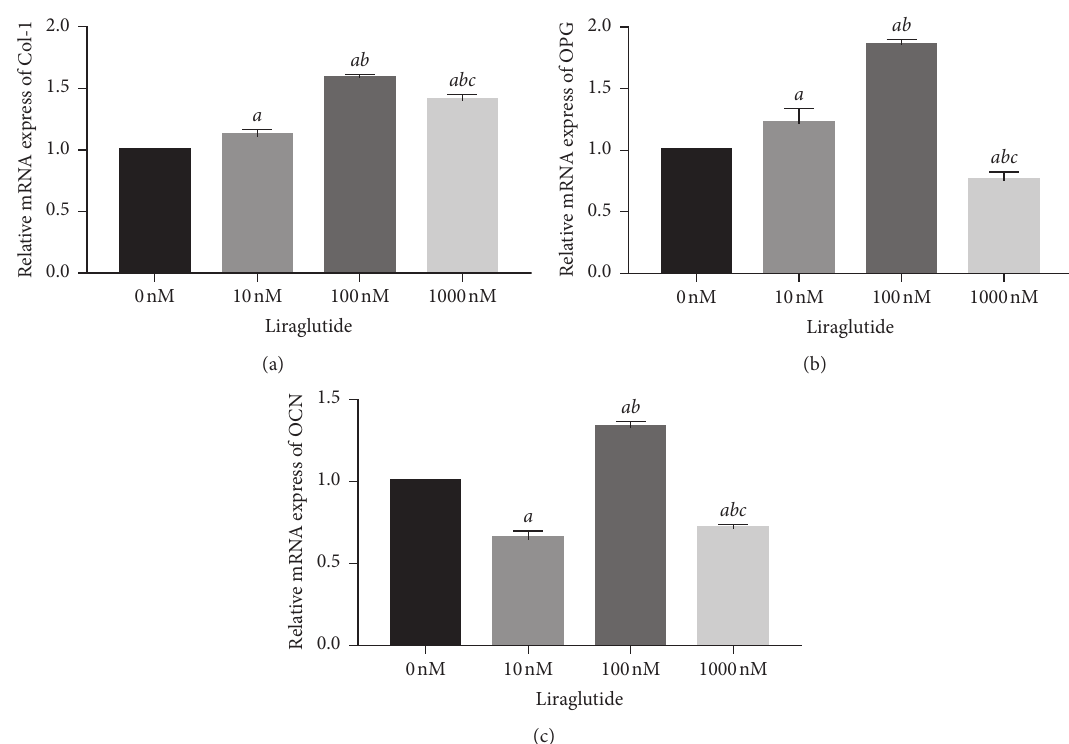
Figure 4: Liraglutide upregulated the Col-1, OPG, and OCN gene expression. MC3T3-E1 cells were treated with different concentration liraglutide for 48h, and then the gene expression of Col-1 (a), OPG (b), and OCN (c) was detected by